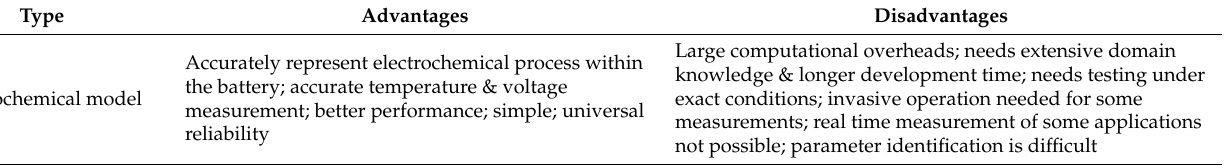
Table 4. Comparison of battery models